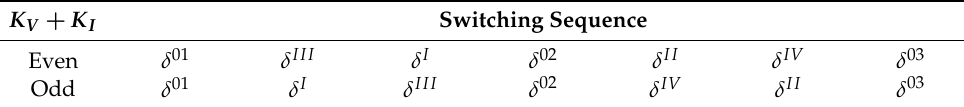
Table 2. Switching sequence for the first half of T s .